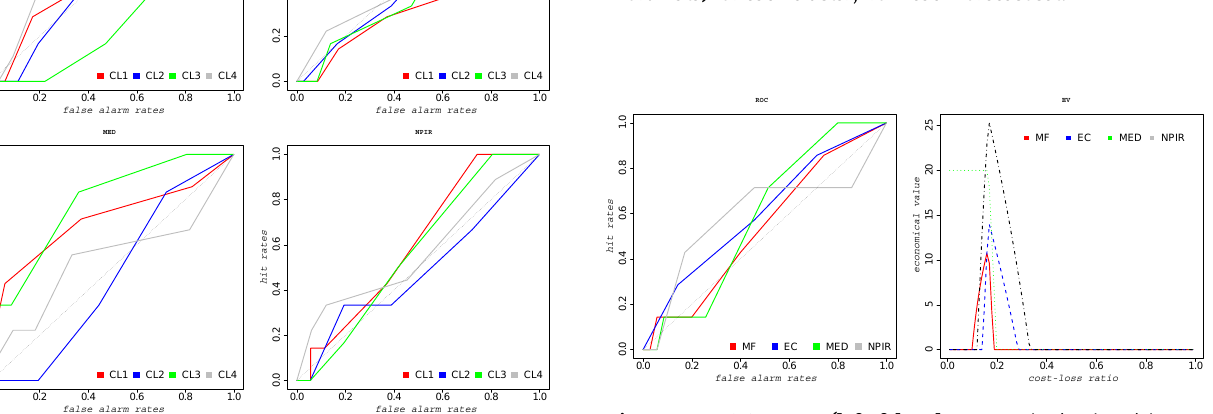
Fig. 6. χψ 200 ROC curves (false alarm rates in abscissa, hit rates in ordinate) for each cluster, from each forecast set.